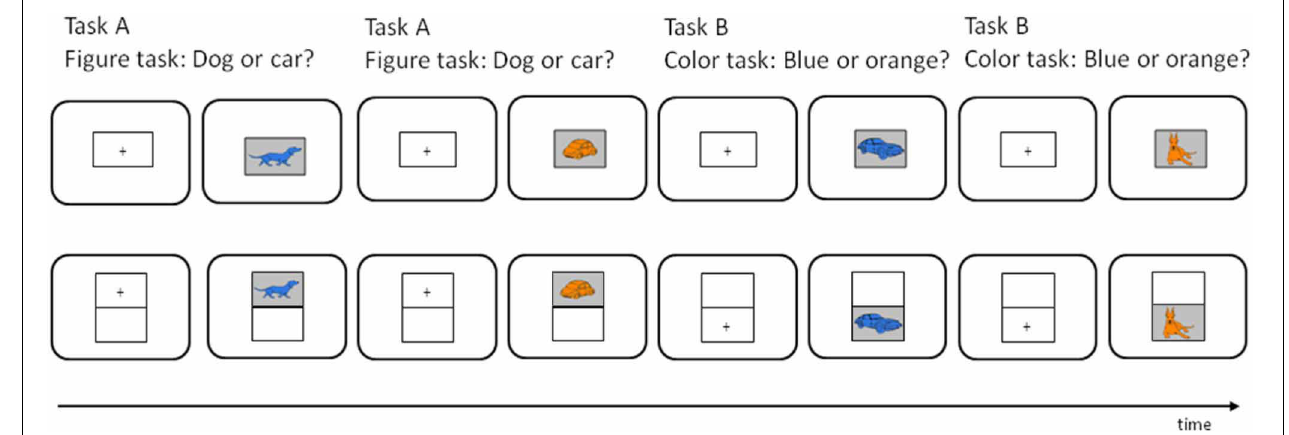
FIGURE 1 | Example of an AABB run in the switching task for the 1-grid group (upper trials) and the 2-grids group (lower trials). In the picture task (task A), children were to decide whether the stimulus was a dog or car, and in the color task (task B), they were to decide